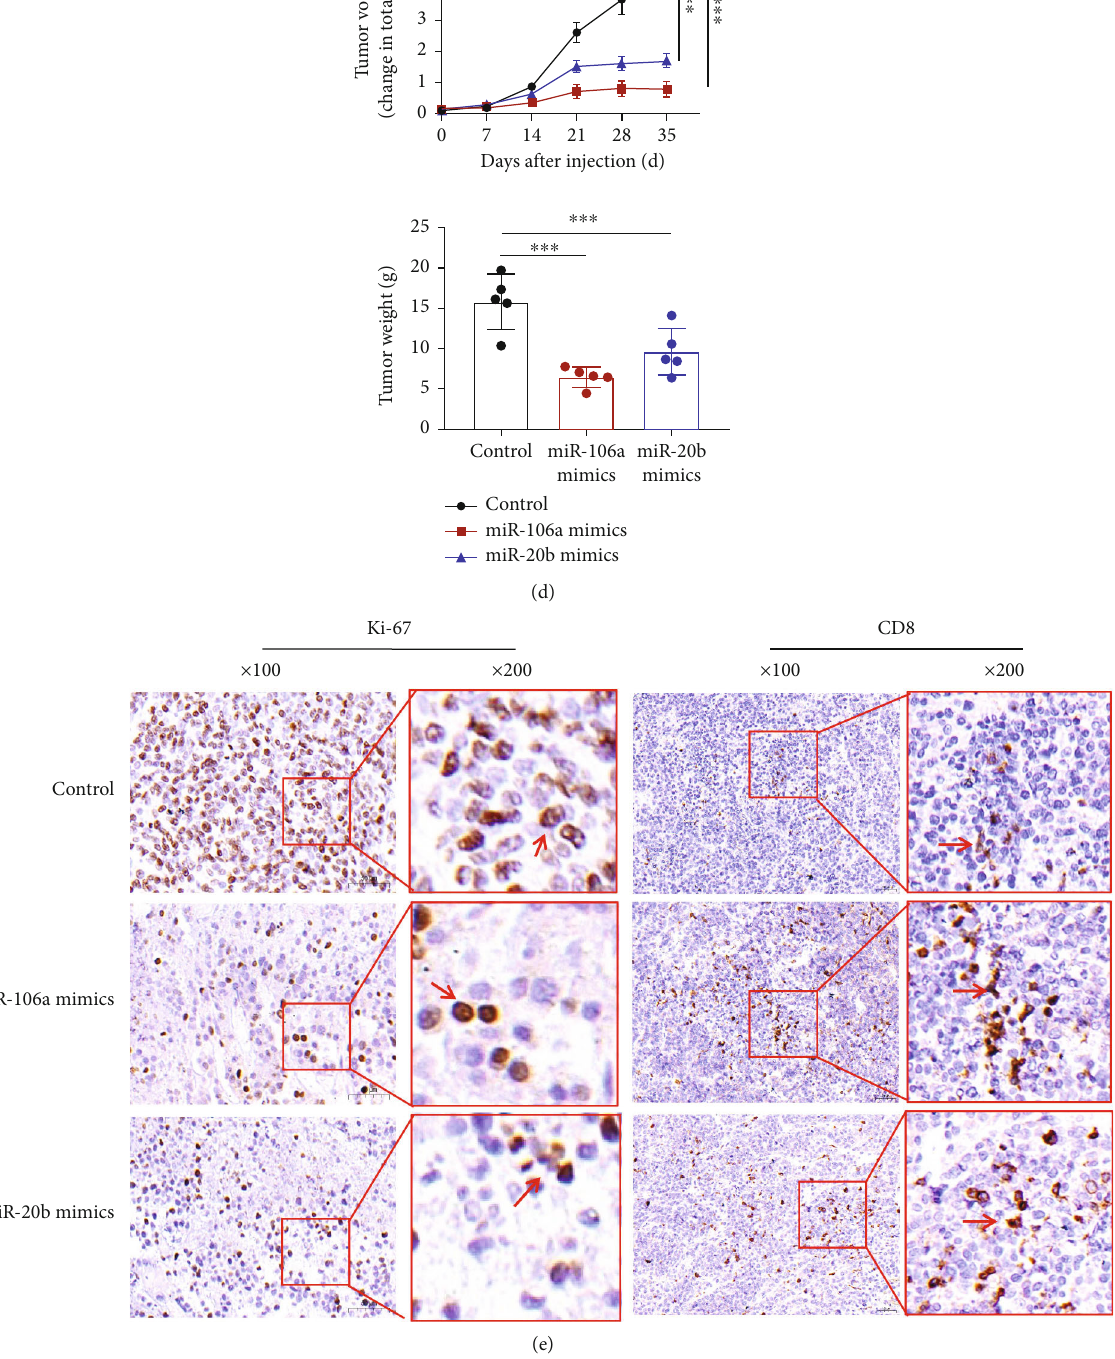
Figure 9: miR-106a/20b mimics increased the antitumour characteristics of DCs and inhibited tumour growth in an immunocompetent syngeneic GSC model. (a) Treatment scheme for GSC-implanted mice. (b) Representative BLI images showing the fi nal tumour volume; (c and d) Measurements of tumour volume and weight. (e) Immunohistochemistry of tumour sections stained with Ki-67 antibodies shows cellular proliferation of the tumour cells.(100x; the arrows indicate the Ki67-positive cells.). CD8+ T cell in fi ltration into the tumour as determined by IHC (arrows indicate the CD8-positive cells). (The red boxes indicate the details at higher magni fi cation (200x).) ∗∗∗ p < 0 : 001